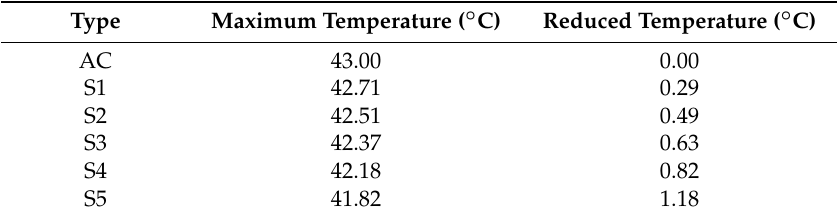
Table 13. Cooling performance of all structures.